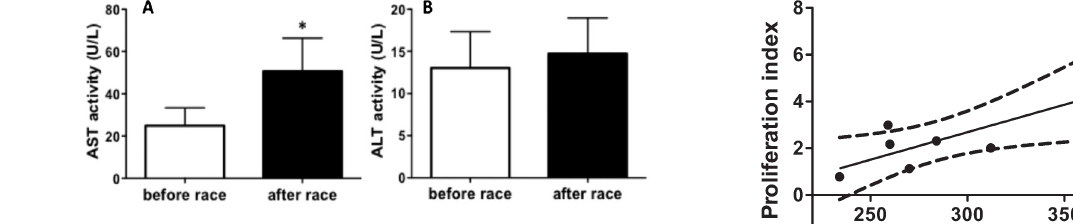
Figure 2. Plasma levels of AST ( A ) but not of ALT ( B ) were elevated after an adventure sprint race. Data are reported as means±SD. AST: aspartate amino transferase; ALT: alanine amino transferase. *P , 0.05, compared to before race (Student paired t -test).